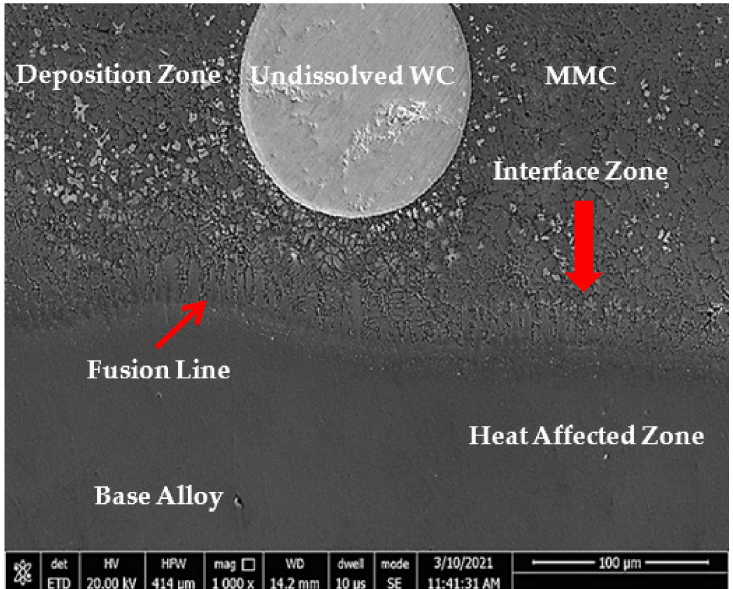
Figure 9. FESEM micrograph of S2 cross section of the whole deposited layer showing three different zones of deposition, interface and